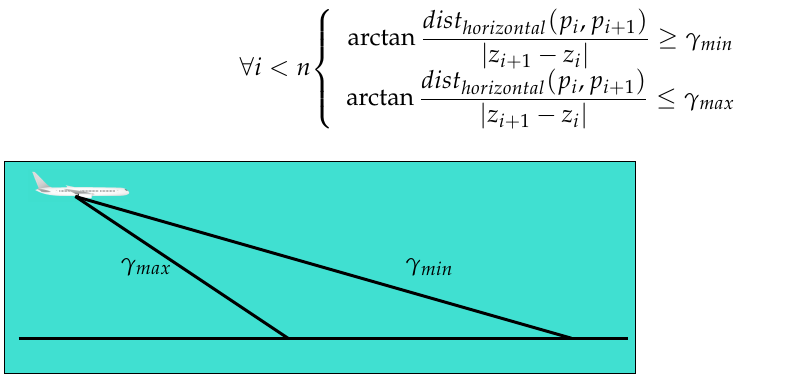
Figure 6. Descent constraint (minimal descent angle = γ min and maximal descent angle = γ max ).